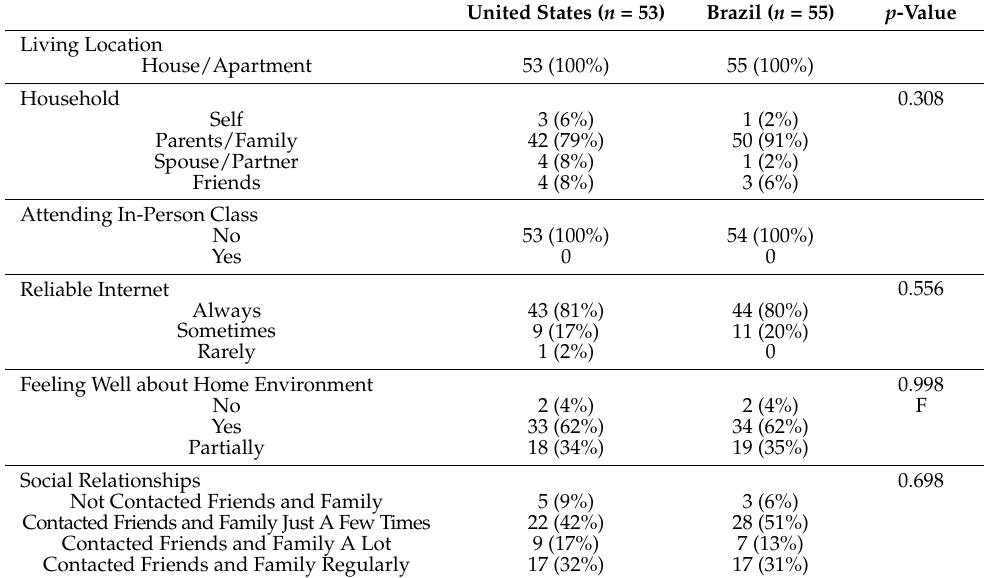
Table 4. Student perceptions and experiences around social world and mental health during the COVID-19